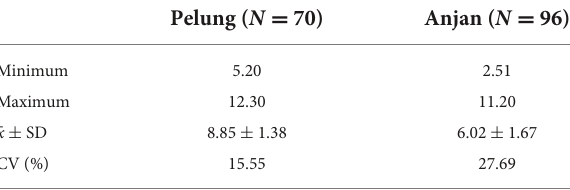
TABLE 2 Comparison of crow length between the Anjian chicken and the Pelung cock.